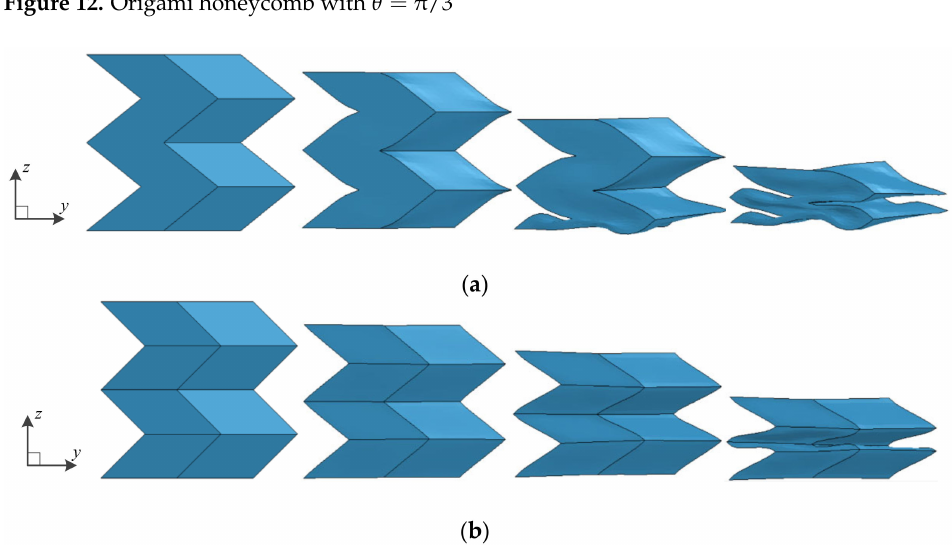
Figure 13. Out-of-plane crushing deformation of two Y-cellular cells when ( a ) r = 6.22 mm and θ = π /3, and ( b ) r = 6.22 mm and θ = π /4.